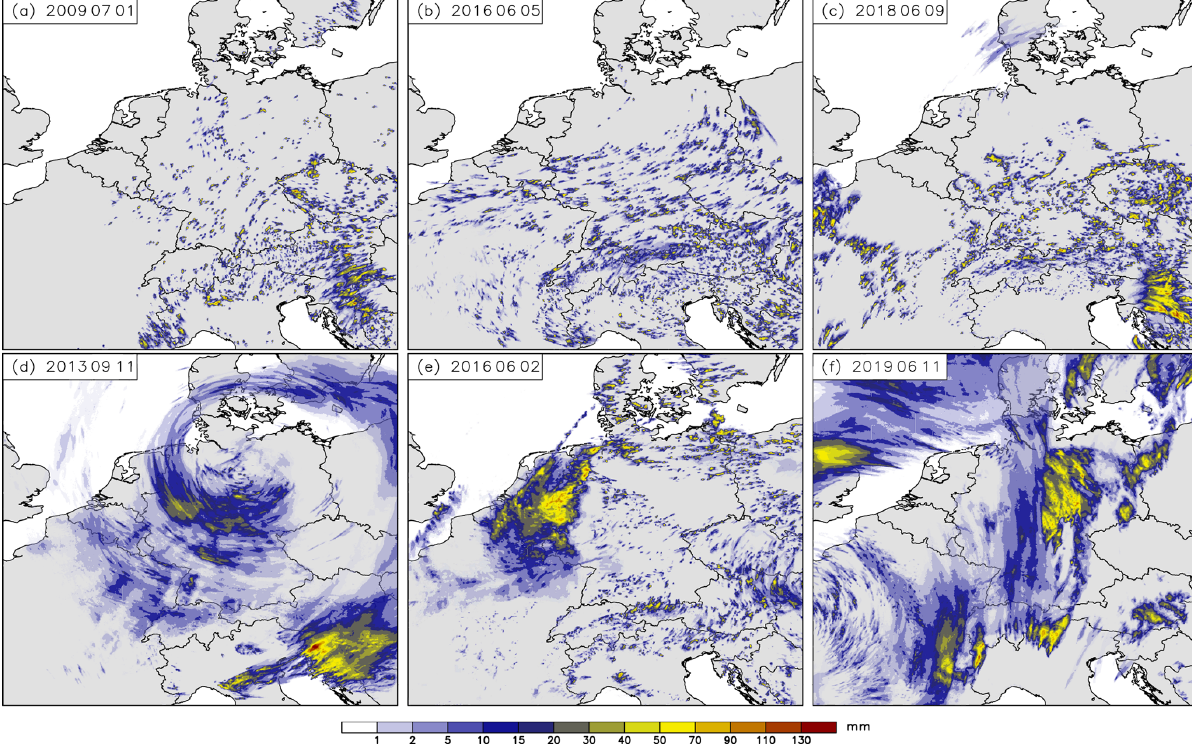
Figure 4. The 24h precipitation amount of the reference runs with continental CCN concentration and broad cloud droplet size distribution ( ν = 0) for the cases with weak (a–c) and strong (d–f) synoptic-scale